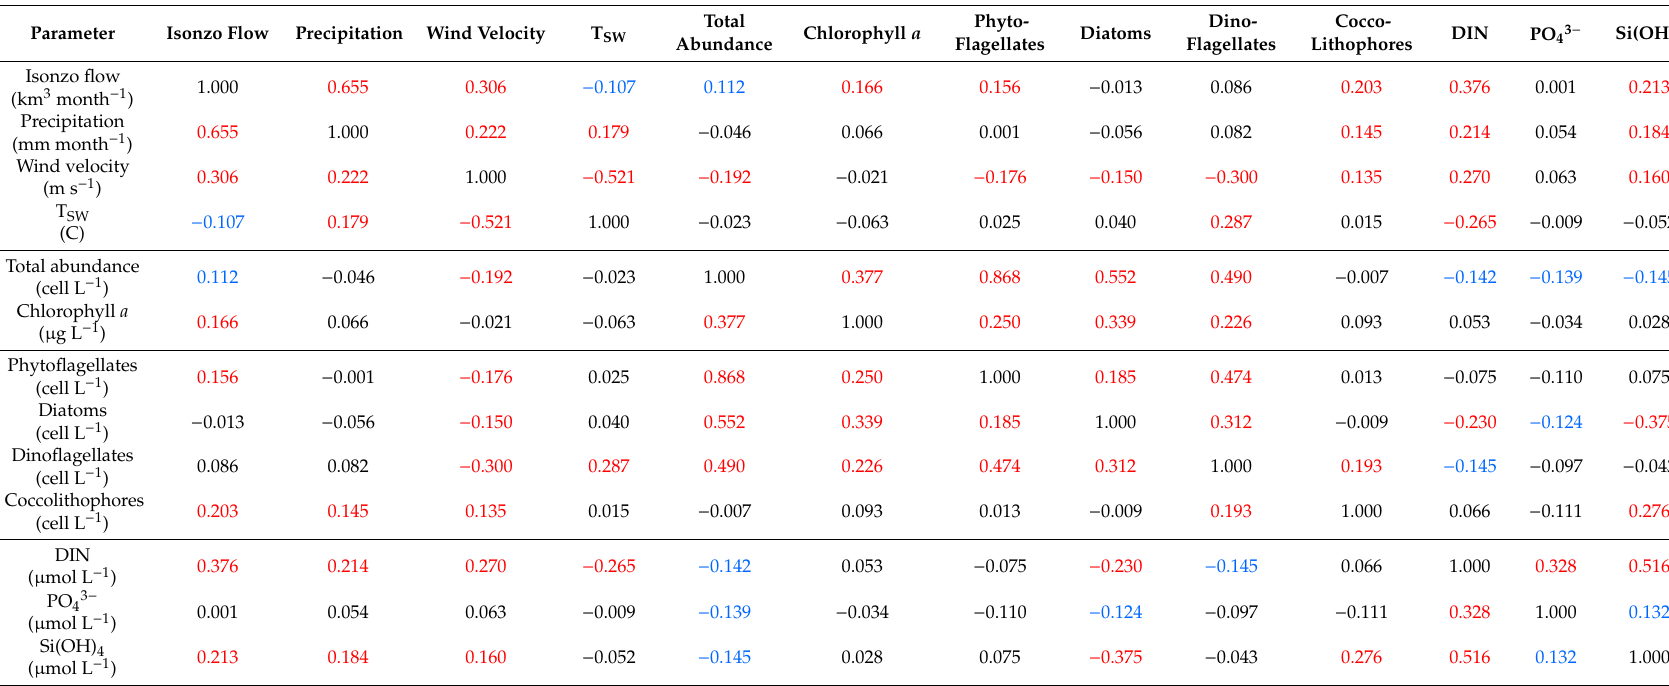
Table A5. Spearman’s Rank-Order Correlation analysis of monthly series of phytoplankton and environmental parameters in the GoT, in 1986–2018. Blue coe ffi